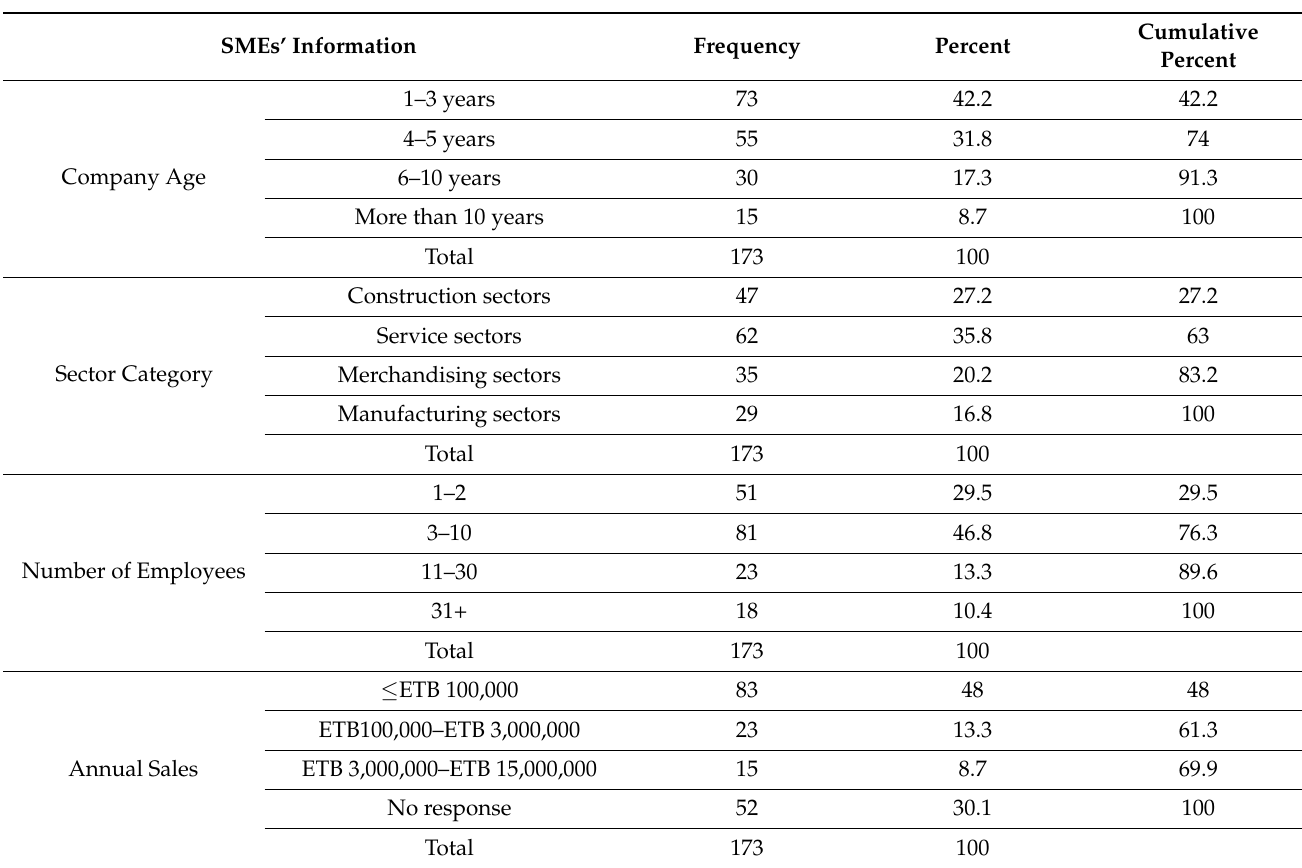
Table 5. SMEs’ background information.